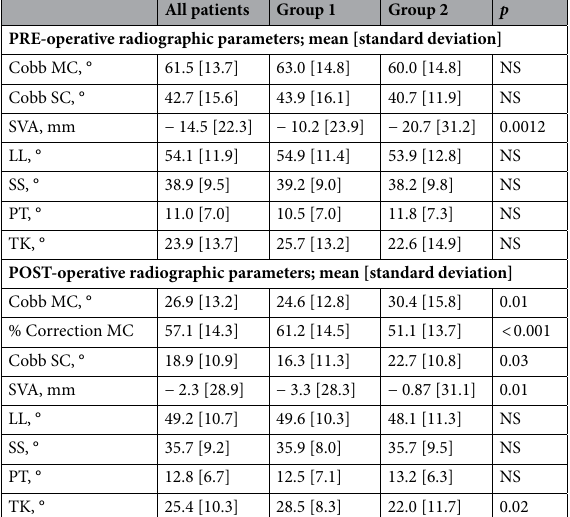
Table 2. PRE-operative radiographic parameters; mean [standard deviation]; analysis performed using IBM SPSS Statistics 21. MC, main curve; SC secondary curve; LL, lumbar lordosis; PT, pelvic tilt; SS, sacral slope; SVA, sagittal vertical axis; TK, thoracic kyphosis; NS, not significant.